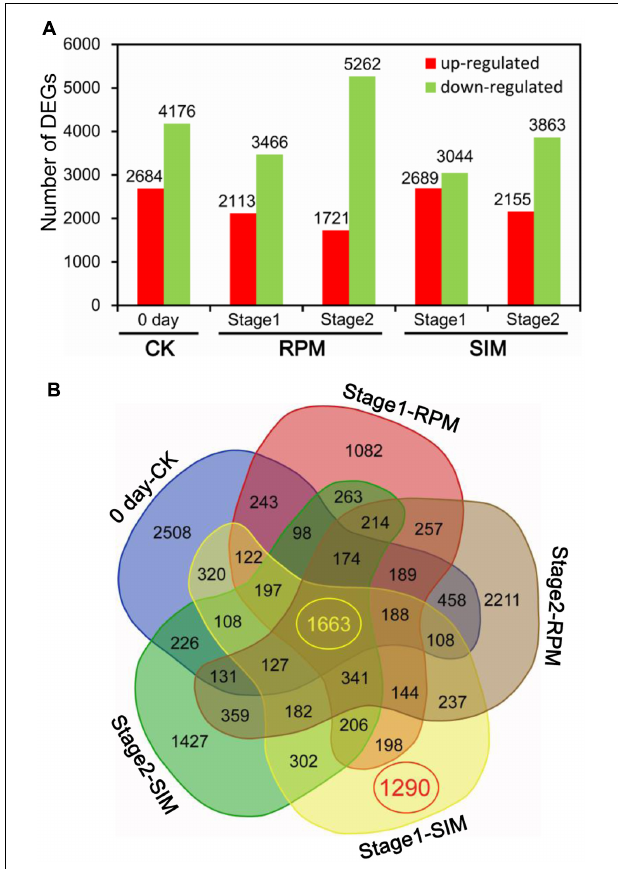
FIGURE 2 | Differentially expressed genes (DEGs) between CXF and CSQ. Five pairwise comparisons were conducted between CXF and CSQ at three stages (CK or day 0, stage 1 and stage 2) on two kinds of media (SIM and RPM). (A) Numbers of upregulated and downregulated DEGs in each comparison. (B) Venn diagram demonstrating specific gene